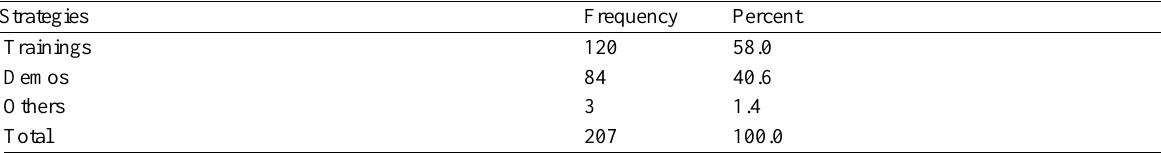
Table 5: Strategies employed by Extension Service Providers